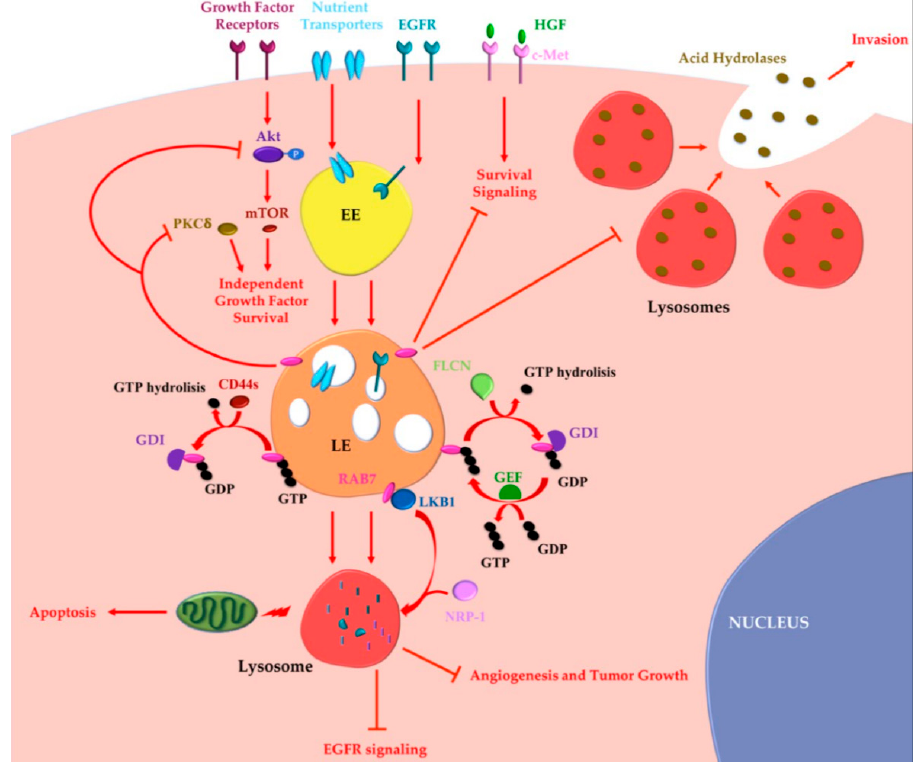
Figure 2. RAB7 oncosuppressor functions in cancer progression. Tumor cells may acquire